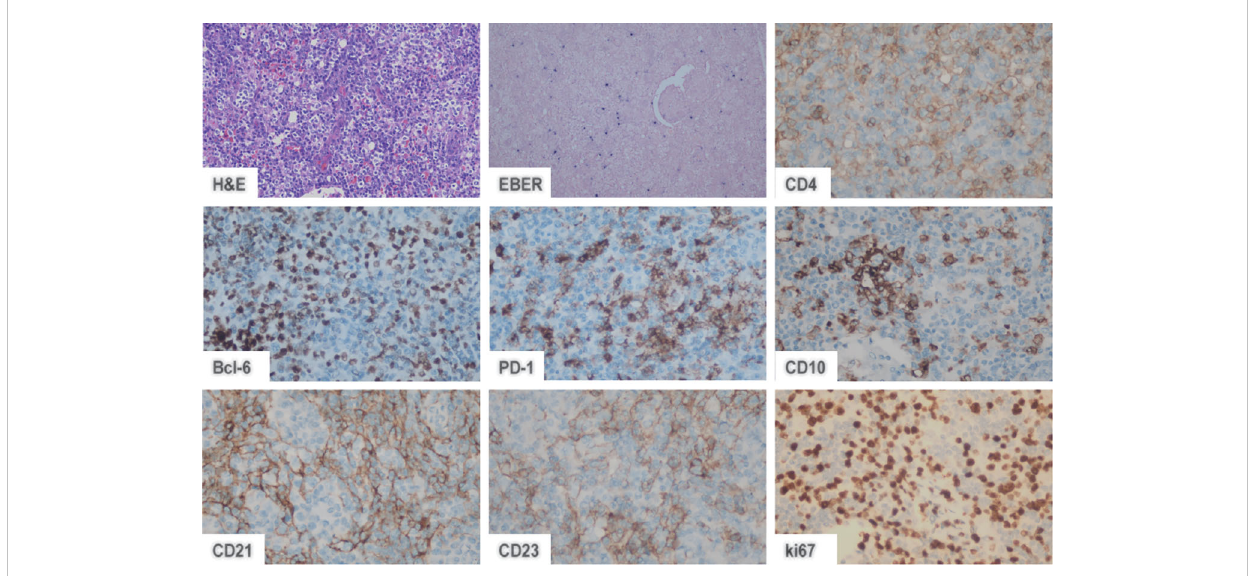
FIGURE 2 AITL immunohistochemistry patterns. In AITL, neoplastic cells are positive for CD4, CD10, Bcl-6, and PD-1, while a few scattered cells are positive for EBER.